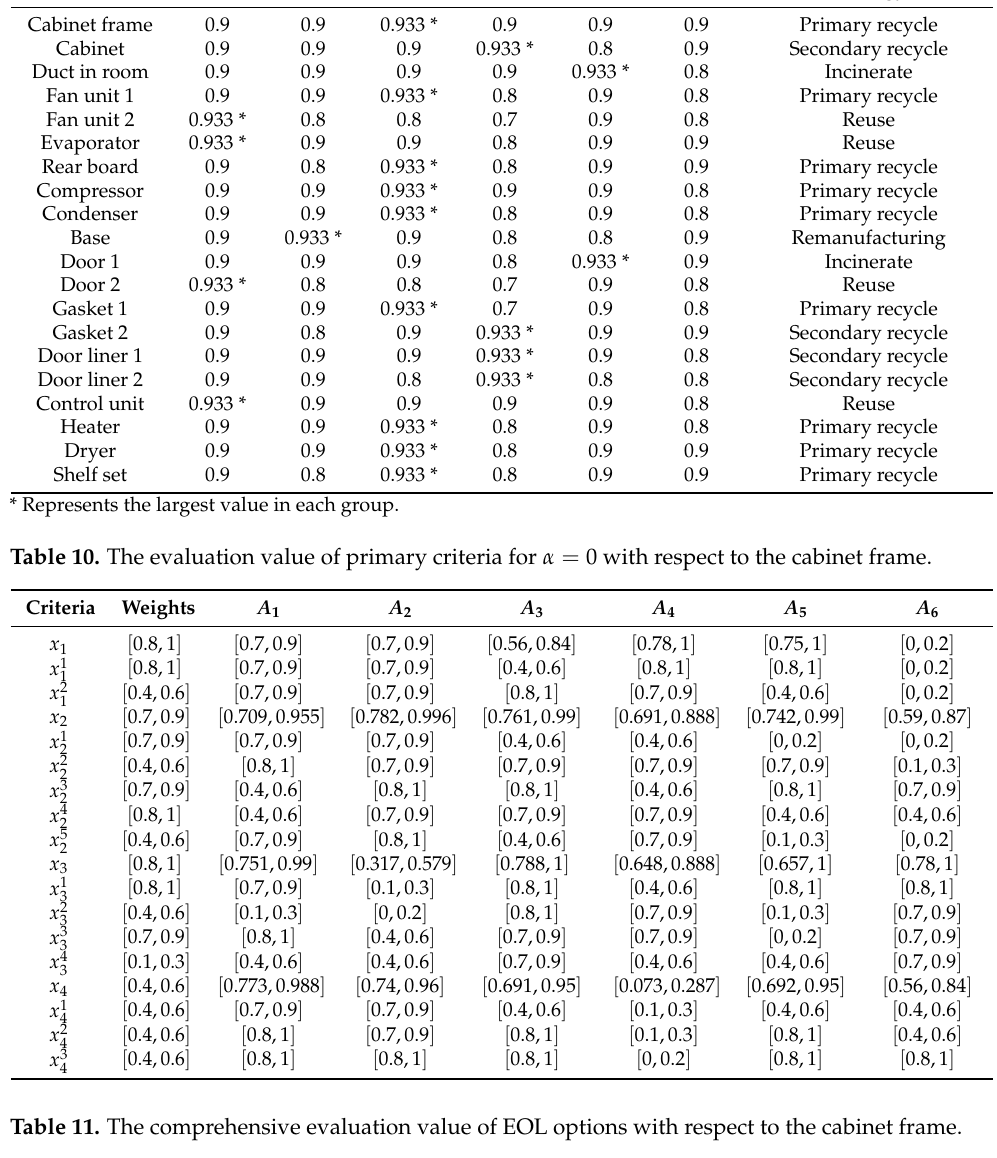
Table 11. The comprehensive evaluation value of EOL options with respect to the cabinet frame. Main